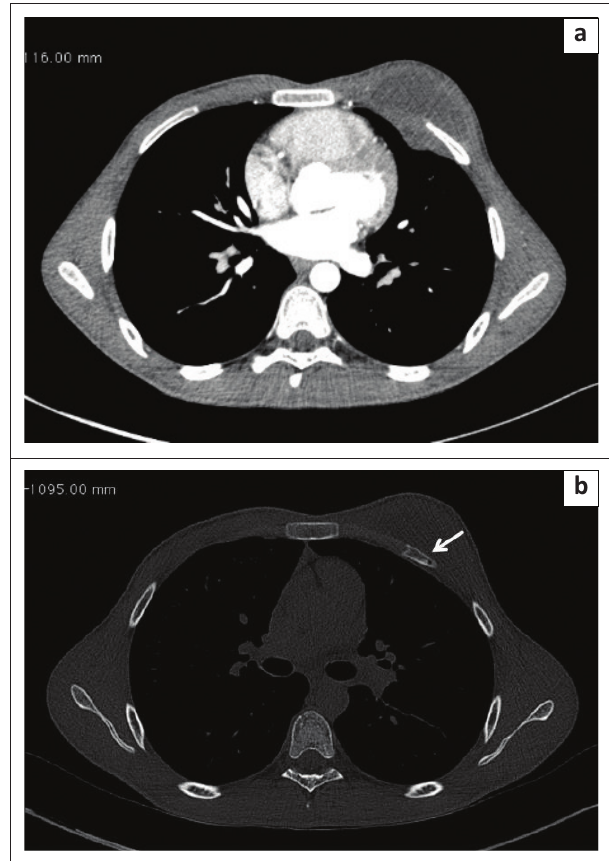
FIGURE 7: An 18-year-old male with swelling on the left chest wall. Post-contrast axial computed tomography soft tissue and bone window images (a, b) illustrate the chest wall collection on the left side with underlying subtle rib erosion (white arrow).